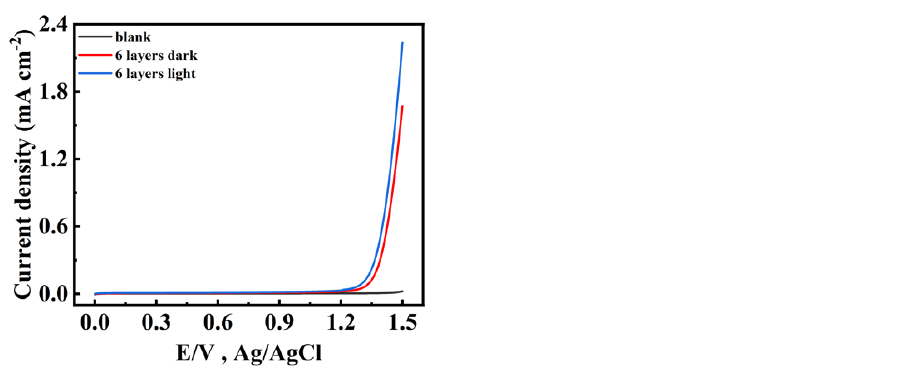
Figure 10. Current density − voltage curves of PDDA/[Ni25/(PDDA − rGO)] 6 /ITO in the dark (red curve), and after illumination of 15 min (blue curve) in 1 M NaAc + HAc (pH 6) buffer solution. Scan rate: 50 mV/s.